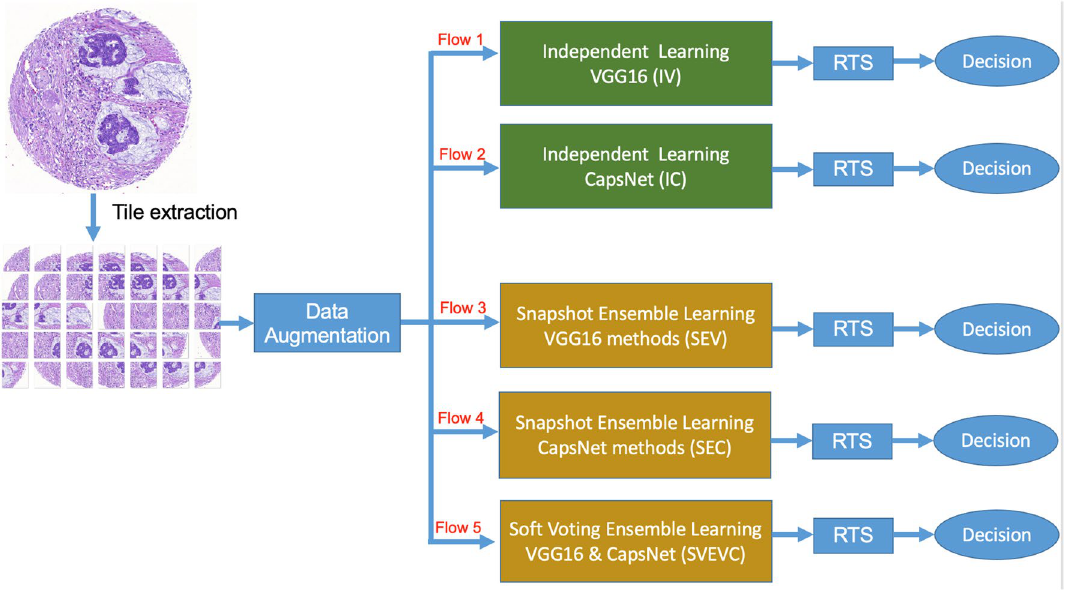
Figure 1. The scheme for TMA core classification considered in this study with five different flows for independent and ensemble learning with VGG16 and CapsNet methods. The inputs of these flows are the tiles extracted from each TMA core with data augmentation. We apply Random Transformation Sampling (RTS) to refine the uncertain cases of deep learning